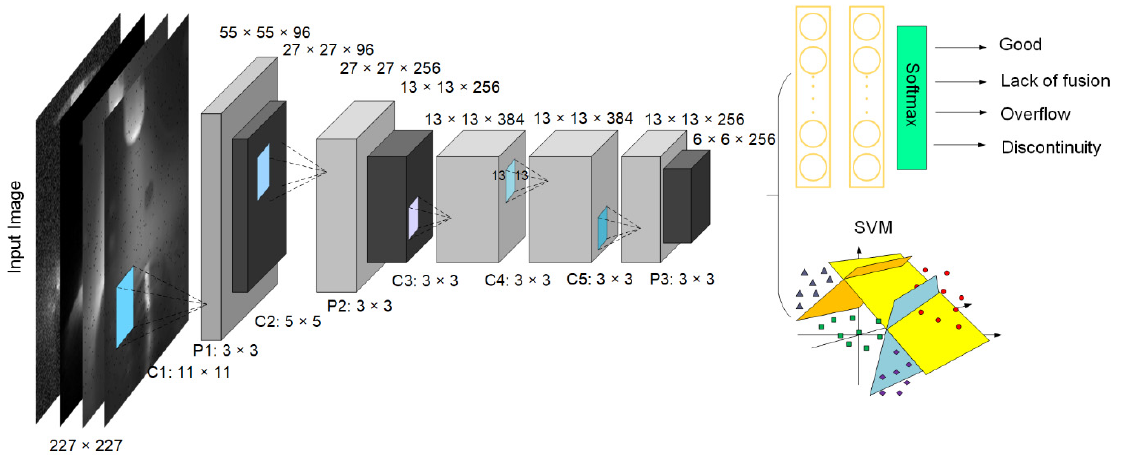
Figure 7. The schematic of convolutional neural network-support vector machine (CNN-SVM)